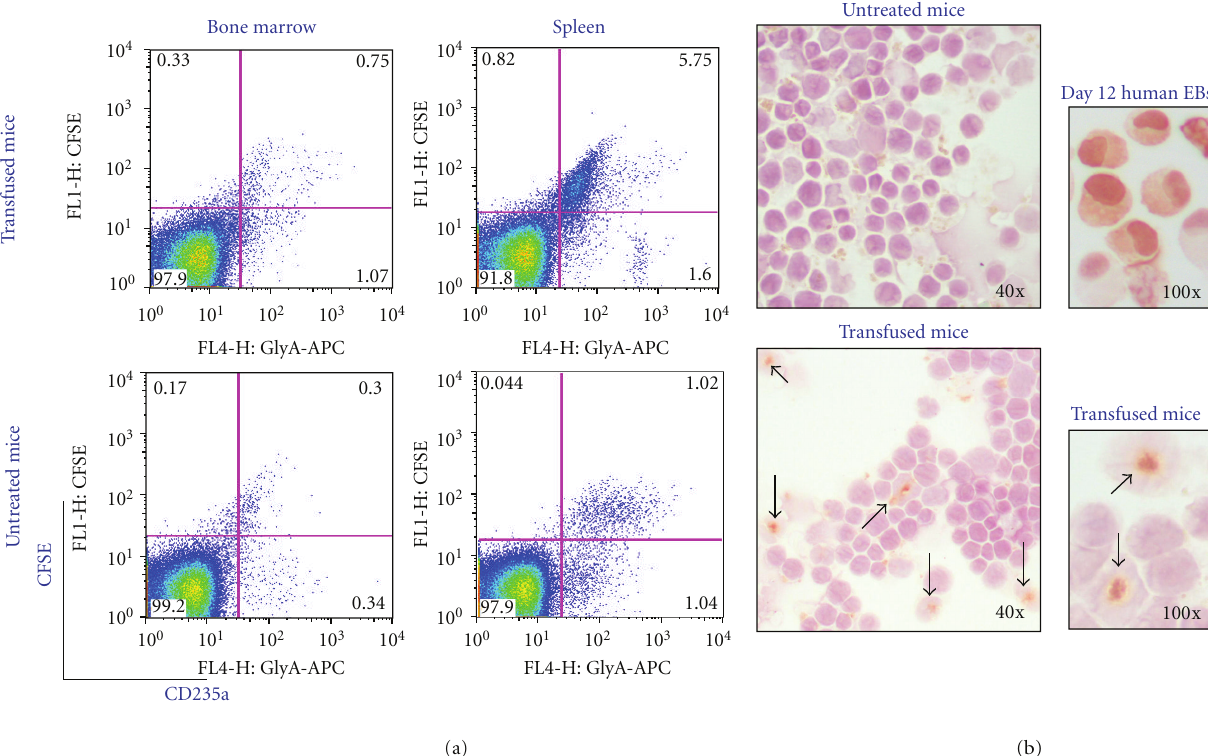
Figure 4: At day 4 after transfusion, human EBs are mostly detectable in spleen of NOD/SCID/IL2R γ null mice. (a) Flow cytometric analysis for human CD235a and CFSE expression of bone marrow and spleen cells from transfused and nontransfused (negative control) NOD/SCID/IL2R γ null mice. The results are representative of those obtained with 2 mice per group (see Table 2 for further details) and are representative of those observed in three separate experiments. (b) Immunocytochemistry for human CD235a of cells from the spleen of untransfused (top left panel) and transfused (lower panels) mice sacrificed 4 days after the human EBs transfusion, as indicated. Cells from control mice (top left panel) are negative while cultured human EBs (top right panel) are all positive. In transfused mice, human CD235a pos cells (arrows) represented up to 18 . 2 ± 5 . 6% of total splenic cells. However, they were trapped inside larger CD235a neg cells, probably macrophages of murine origin. Magnifications 40x and 100x, as indicated.